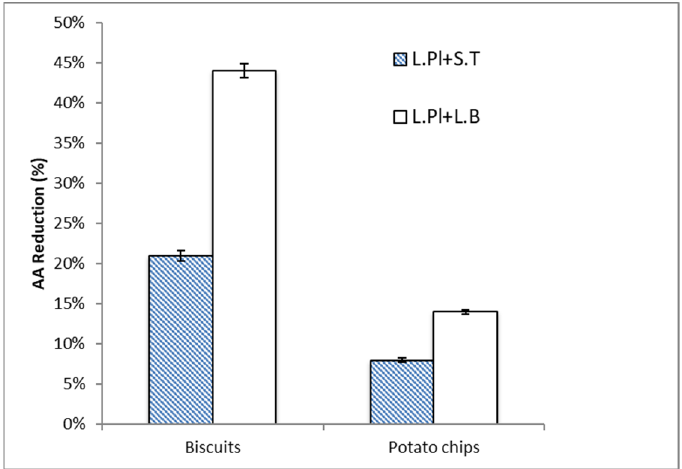
Figure 4. The acrylamide (AA) reduction ability of two formulas of probiotic bacteria: Lactiplantibacillus plantarum ATCC14917 (50%) + Streptococcus thermophilus ATCC19258 (50%) ( L. Pl. + S. T. ) and Lactiplantibacillus plantarum ATCC14917 (50%) + Lactobacillus bulgaricus ATCC11842 (50%) ( L. Pl. + L. B. ), when exposed to biscuits and potato chips. Probiotic concentration was 10 8 CFU/mL. Incubated at 37 °C for 4 h at pH 6.5–7.0. Expressed as AA reduction percentage. Data are the mean of three replicates.